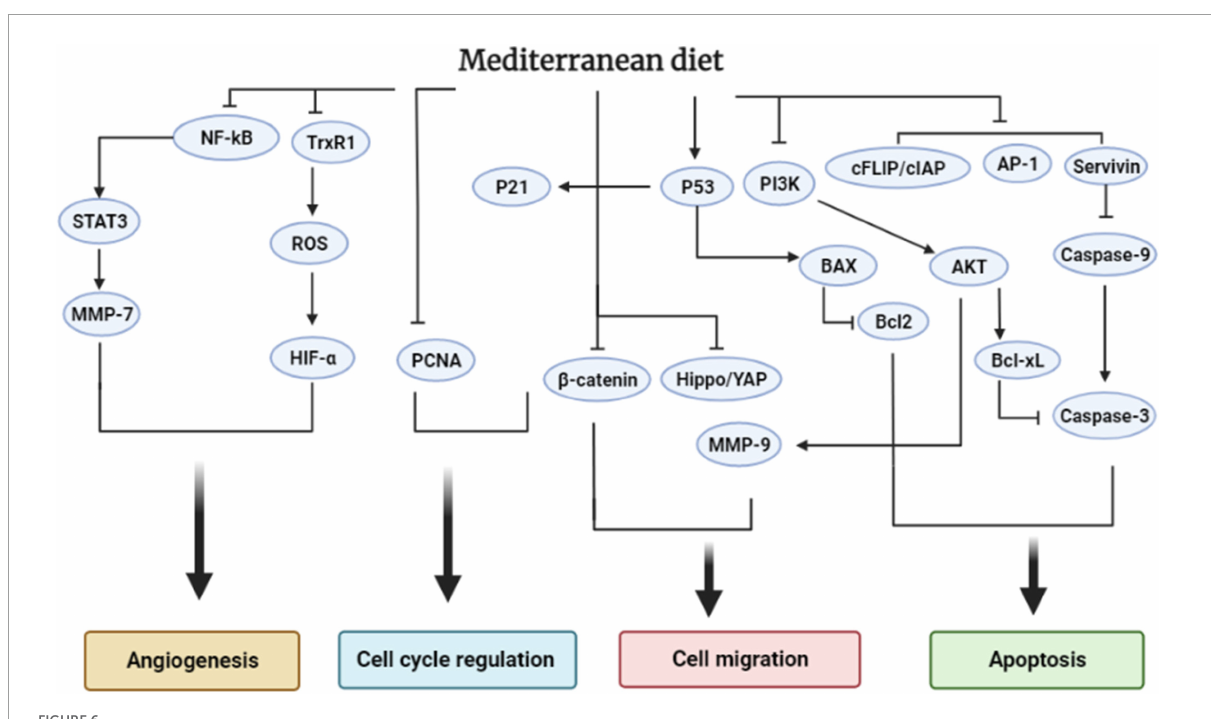
FIGURE6 The effect of the Mediterranean diet on the cellular signaling pathways that regulate colorectal cancer